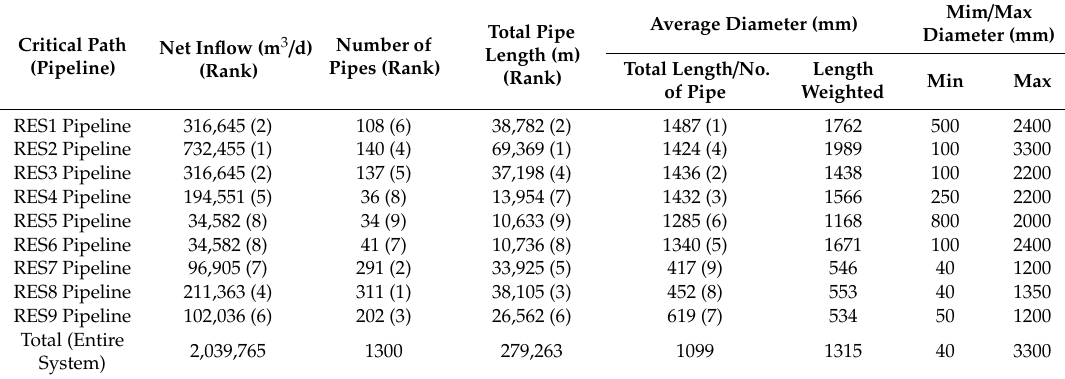
Table 2. Water Supply and Pipe Characteristics of Each Critical Path.